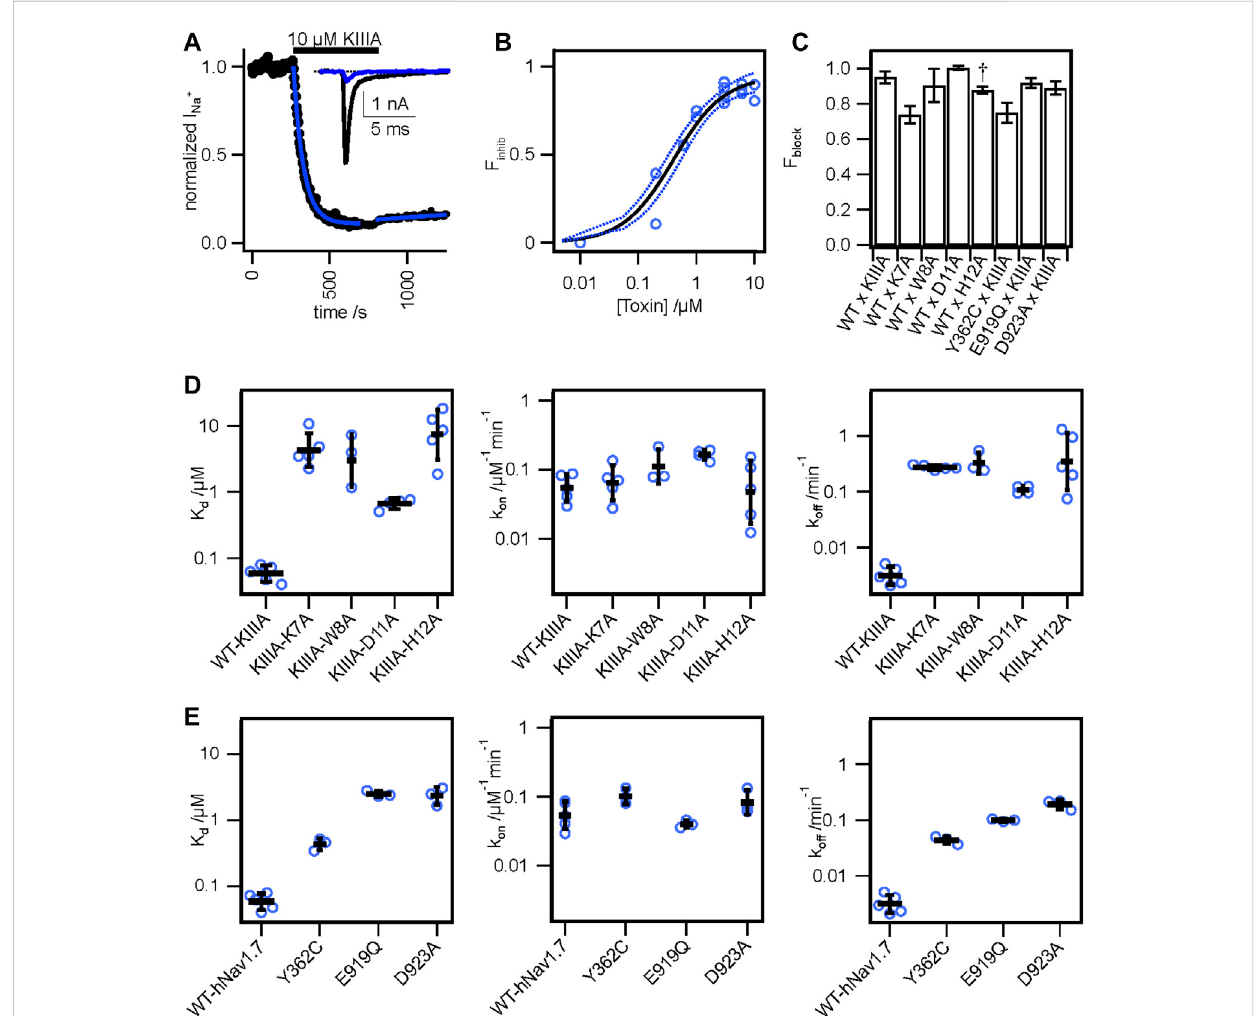
FIGURE 2 Functionalstudiesoftoxinvariantsandchannelmutations. (A) NormalizedpeakI Na fromawholecellvoltageclampexperimentwith10 μ MWT-KIIIA against WT-hNa V 1.7, resulting in incomplete block and (inset) raw current traces before toxin (black) and after toxin (blue). (B) Hill- fi t (black) and 95% con fi dence interval (dashed blue) of concentration-response data for WT-KIIIA against hNa V 1.7 in HEK293 cells (IC 50 = 0.41 ± 0.16 μ M mean ± SD, n = 2 – 4 cells per concentration), from maximum block recorded during association experiments. Empty circles represent single cells. (C) Calculated Fractional block (see Materials and methods ) for toxin variants and channel mutants (mean ± SEM). † WT x H12A block data were reported previously (McArthur et al., 2011). (D) Kinetic data from electrophysiological measurements show general agreement with Rosetta predicted energies. Alanine variantsofresiduesK7,W8,D11,andH12showedsigni fi cantreductionsinaf fi nity(K d )(left),littlechangeinassociation( k on )(middle),butmarkedincreases intoxindissociation( k off )(right).Barsaregeometricmean±SDfrom n =3 – 5cellspervariant(reportedinTable1),andemptycirclesrepresentsinglecells. (E) Mutations to channel residues demonstrate reductions in af fi nity of the WT-KIIIA from Y362C, E919Q, and D923A (left), little change to toxin association (middle), and increases in dissociation (right), similar to the effects of toxin variants. Bars are geometric mean ± SD from n = 3 – 5 cells per variant (reported in Table 2), and empty circles represent single